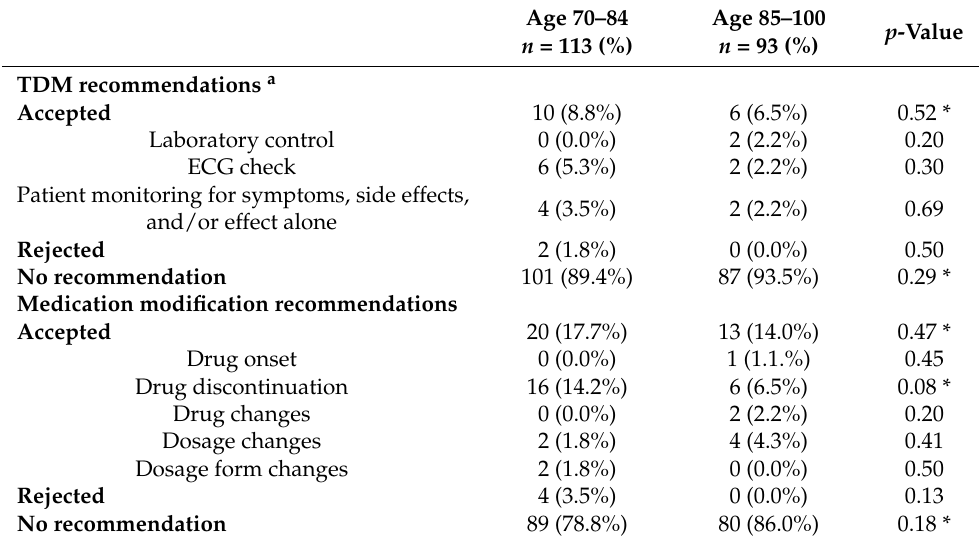
Table 6. The number of patients in both age groups with accepted or rejected pharmaceutical recommendations for antipsychotic use, divided into therapeutic drug monitoring (TDM) and medication modifications.